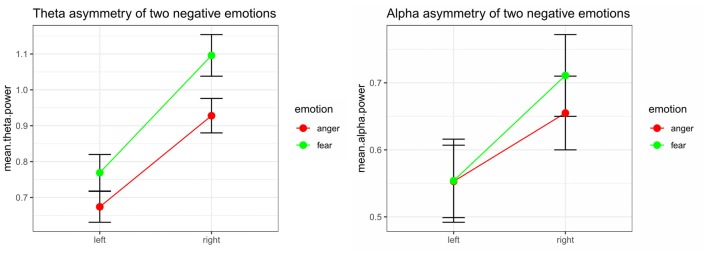
Significant emotion category × hemisphere interactions for the mean power values of theta and the theta band at the Fleft/Fright site between anger and fear.